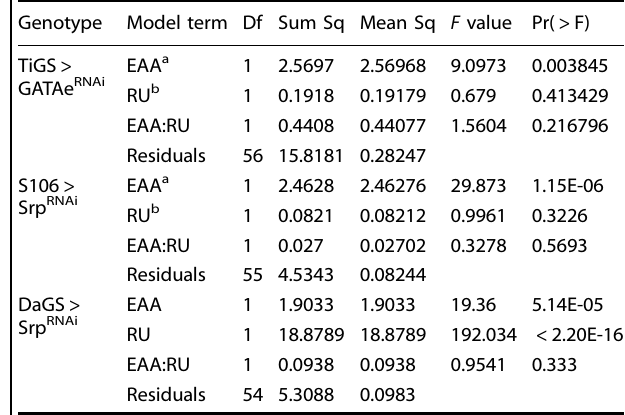
Table 5. ANOVA of fecundity of fl ies expressing RNAi against GATA factors